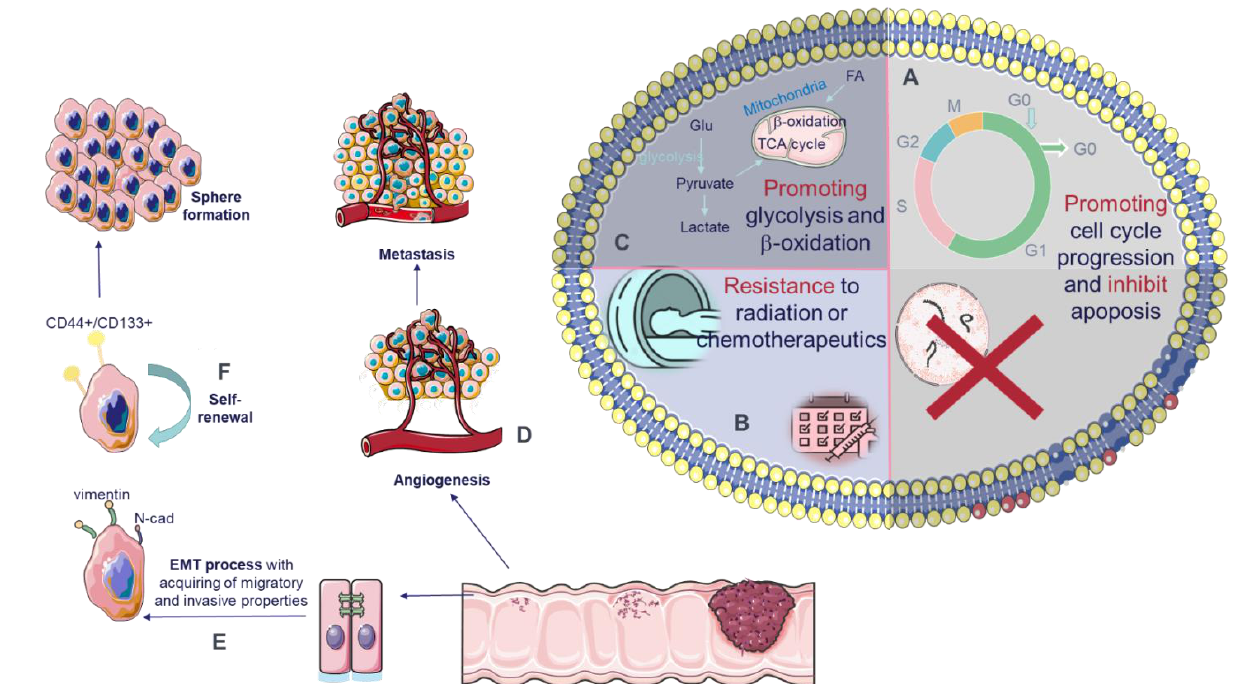
Figure 3. Functions of oncogenic circRNAs in colorectal cancer. ( A ) Oncogenic circRNAs can regulate cell cycle as they allow the passage from one phase into another (Examples: hsa_circ_0000512 (hsa_circ_000166); hsa_circ_102958 (hsa_circ_0003854); hsa_circ_0000069 (hsa_circ_001061, circSTIL)). Part of oncogenic circRNAs is shown to suppress the